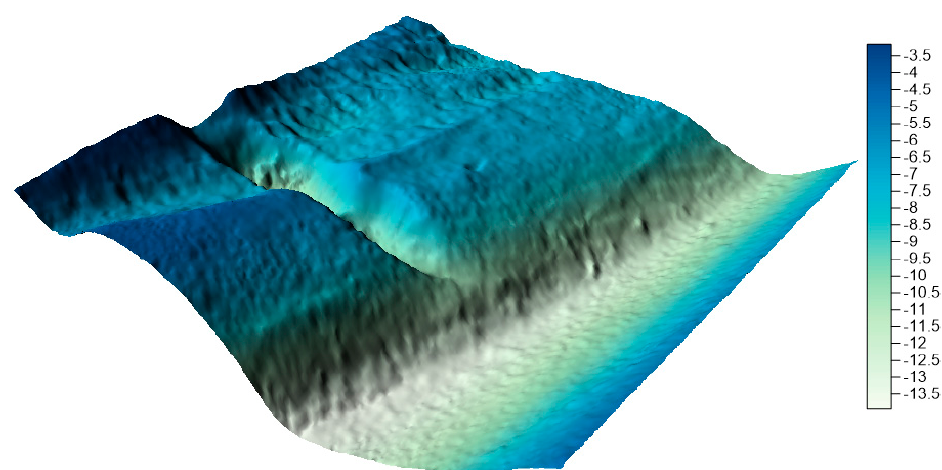
Figure 15. Surface obtained by integrated dataset no. 1 for the Inski canal area.